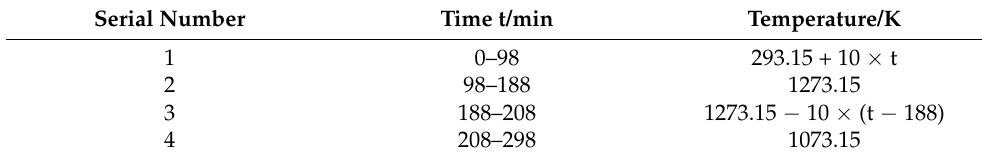
Table 2. 1000–800 ◦ C temperature-window tube-furnace-temperature